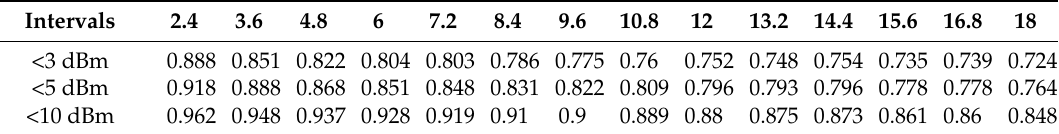
Table 3. The statistics probabilities of absolute RSS differences ranges between manual radio map and the IDW interpolated ones.